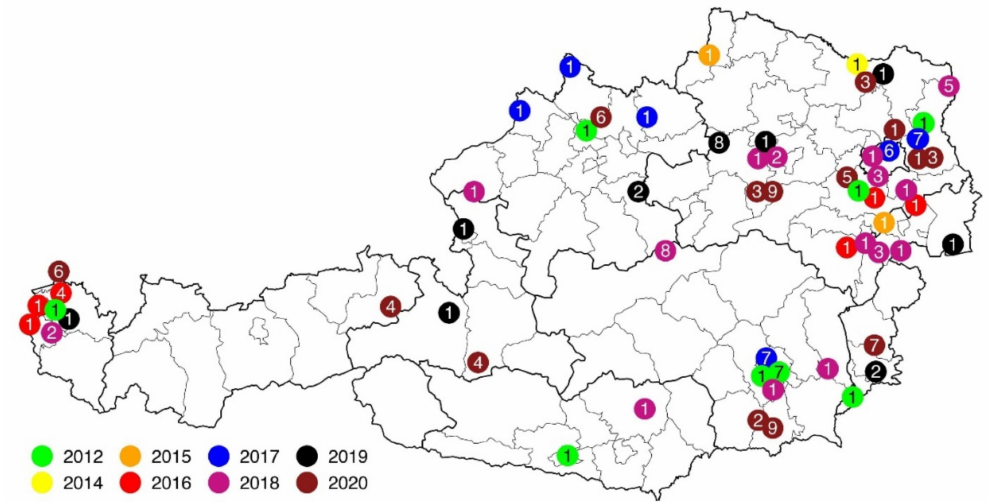
Figure 1. Map of Austria showing locations of detected cases of trichomonosis in songbirds from 2012 to 2020. Each color represents a particular year; the number in the circle determines the bird species: (1) Greenfinch; (2) Chaffinch; (3) Goldfinch; (4) Bullfinch; (5) Hawfinch; (6) Eurasian siskin; (7) Great tit; (8) Yellowhammer; (9)